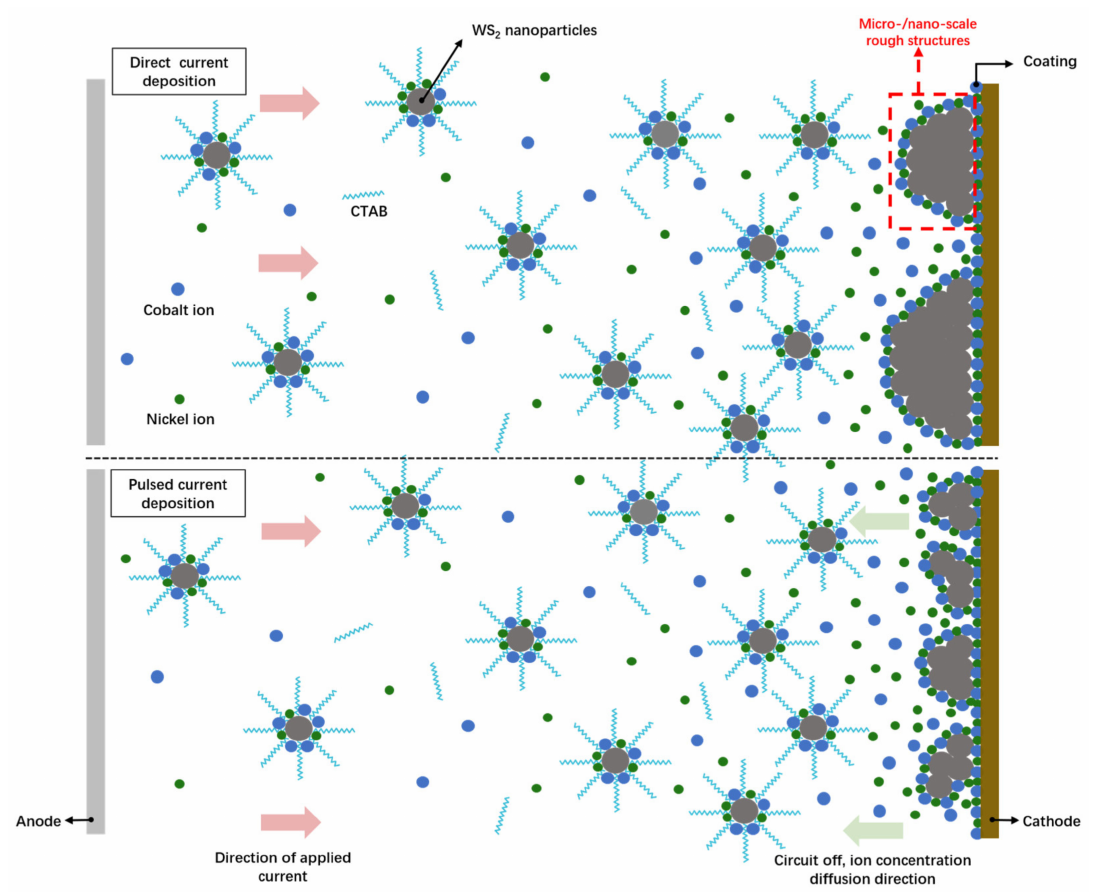
Figure 14. Schematic diagram of the mechanism of forming micro/nanoscale structures on substrates using DC and PC